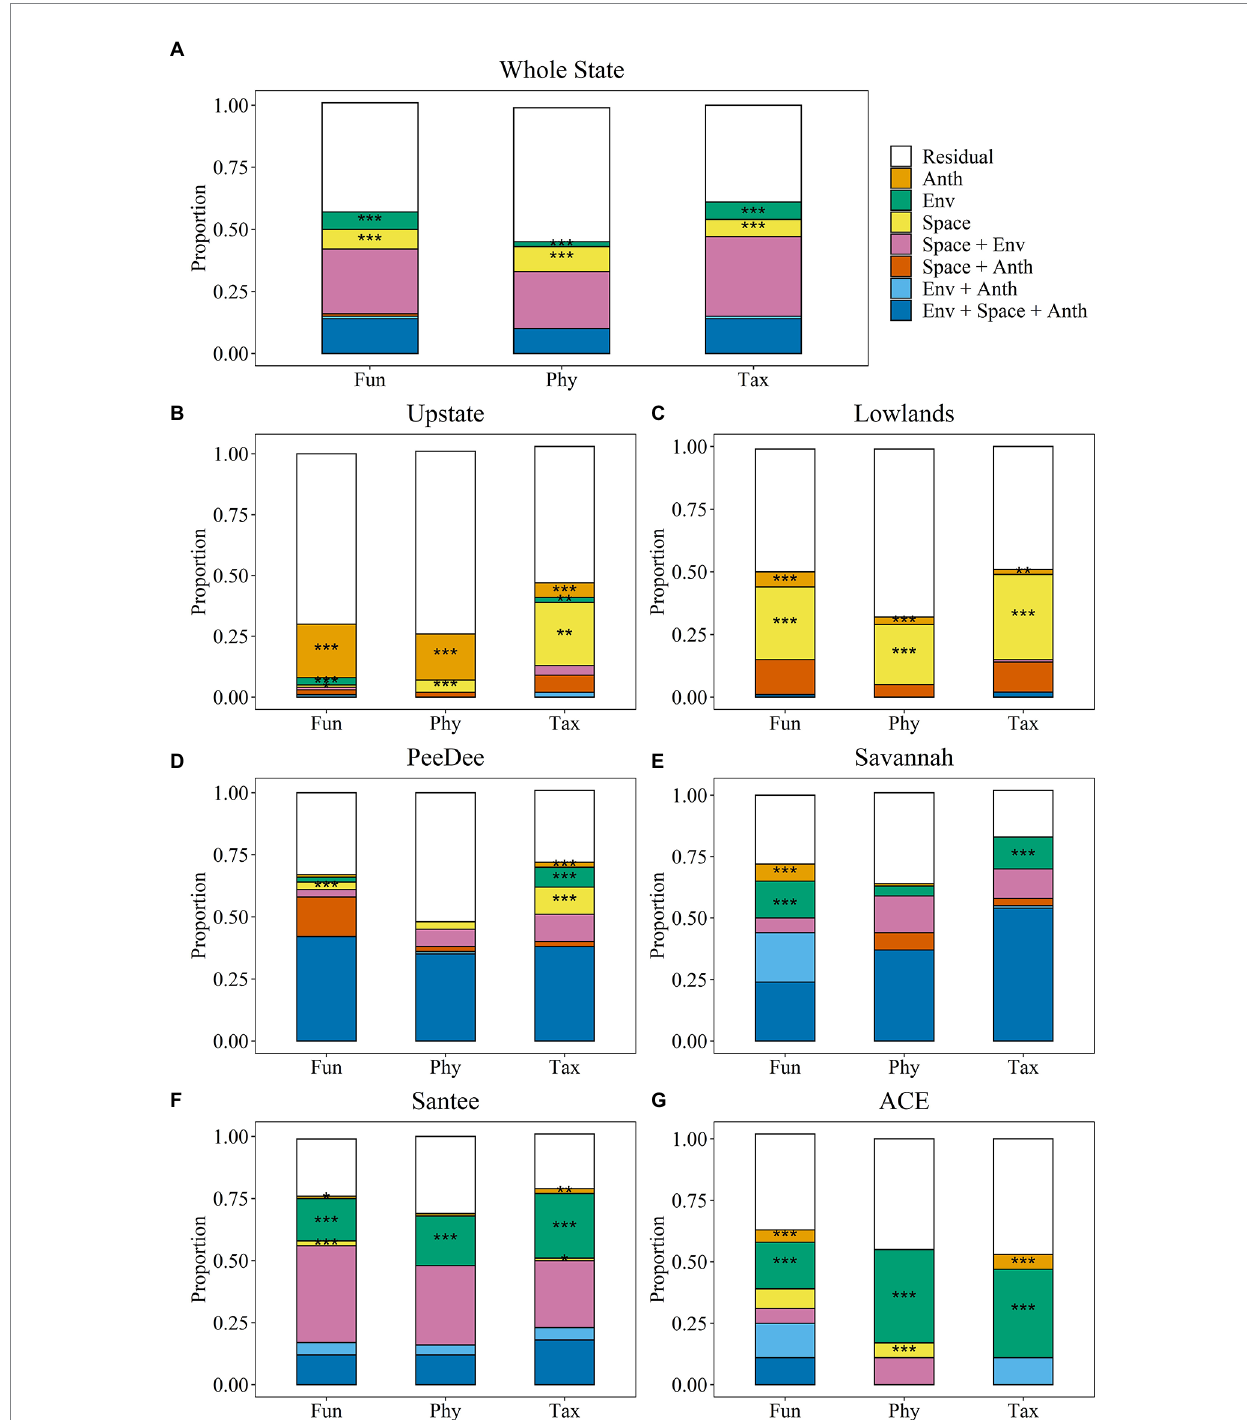
FIGURE 3 Variation partitioning results for stream fish beta diversity for the whole state (A) delineation, the fall line delineation of the upstate (B) and lowlands (C) , as well as the watershed delineations of the PeeDee (D) , Savannah (E) , Santee (F) , and ACE (G) watersheds. Asterisks show significance of the pure fractions of variation partitioning; * p < 0.05, ** p < 0.01, *** p < 0.001. ANTH, Anthropogenic; ENV, Natural Environmental. Fun = functional; Phy = phylogenetic; Tax =